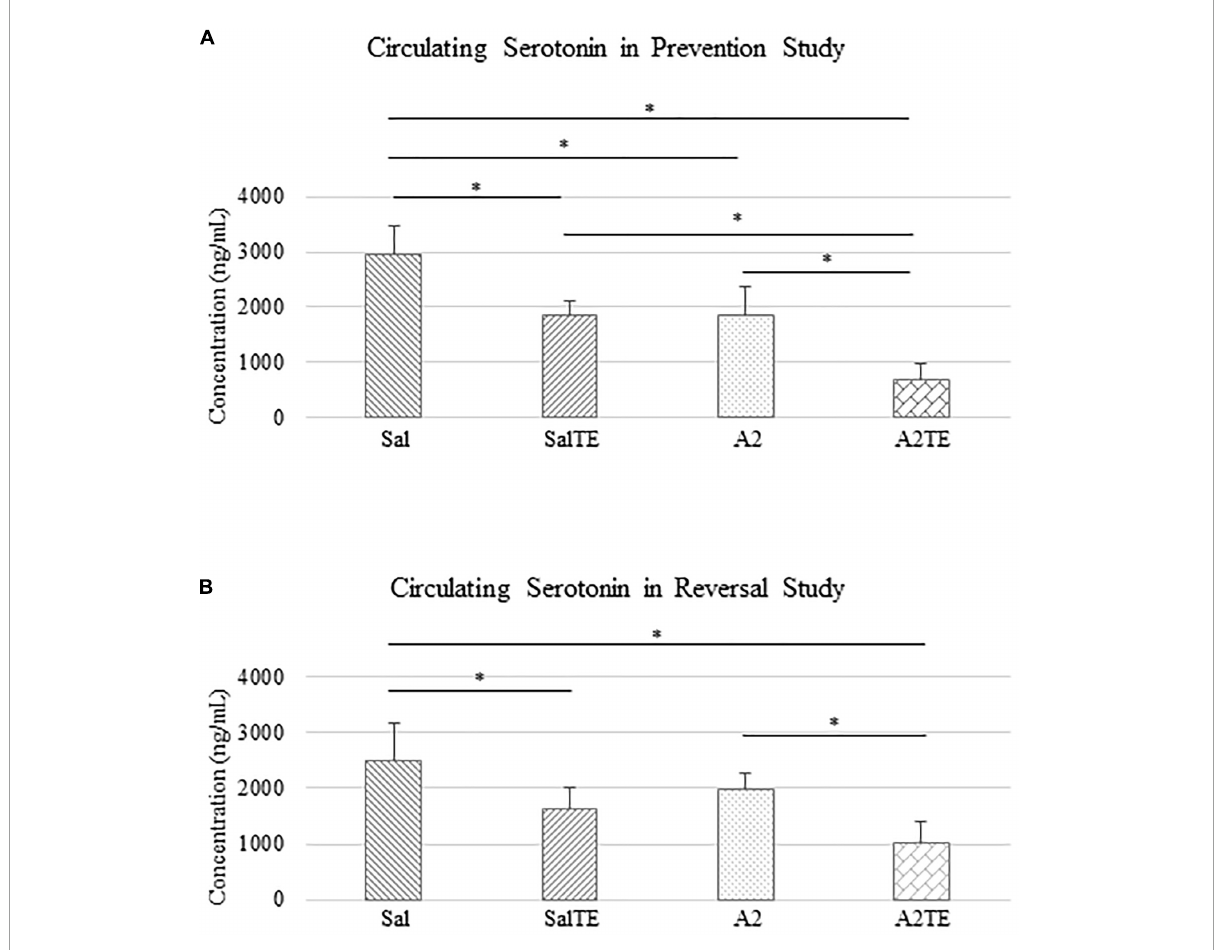
FIGURE4 Circulating serotonin level comparison across treatments in prevention (A) and reversal (B) studies. Asterisk indicates significant difference ( p <